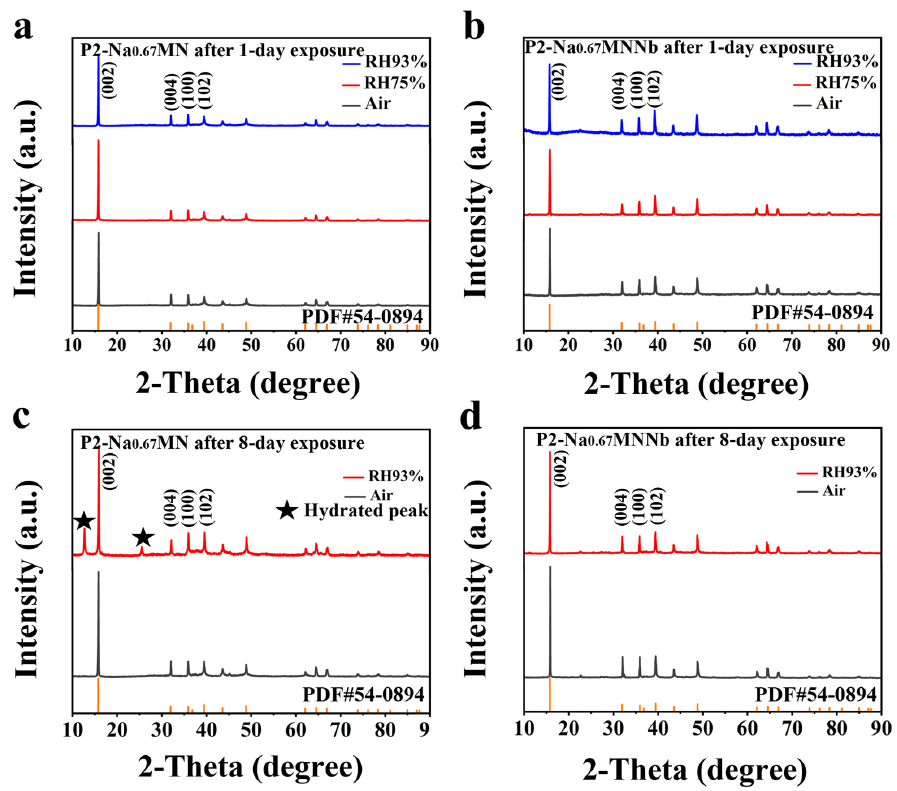
Figure 2. The XRD patterns of ( a ) P2-Na 0.67 MN and ( b ) P2-Na 0.67 MNNb samples exposed in different atmospheres after 1 day of exposure. The XRD patterns of ( c ) P2-Na 0.67 MN and ( d ) P2-Na 0.67 MNNb samples exposed in different atmospheres after 8 days of exposure. To further investigate the air stability of P2-Na 0.67 MNNb, P2-Na 0.67 MNNb was ex- posed to air and RH93% humid environment for 20 days, respectively. The XRD pa tt ern shows (Figure S3a) that the peak position was not shifted and no hydration peak was formed. The doping of Nb element e ff ectively improved the air stability of P2-Na 0.67 MN.